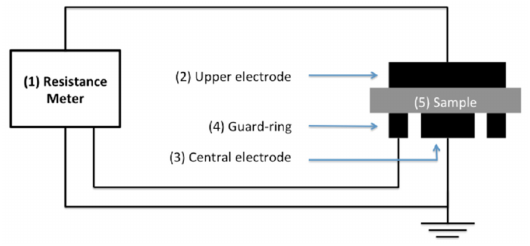
Figure 4. Schematic diagram of the experimental setup to measure volume and surface